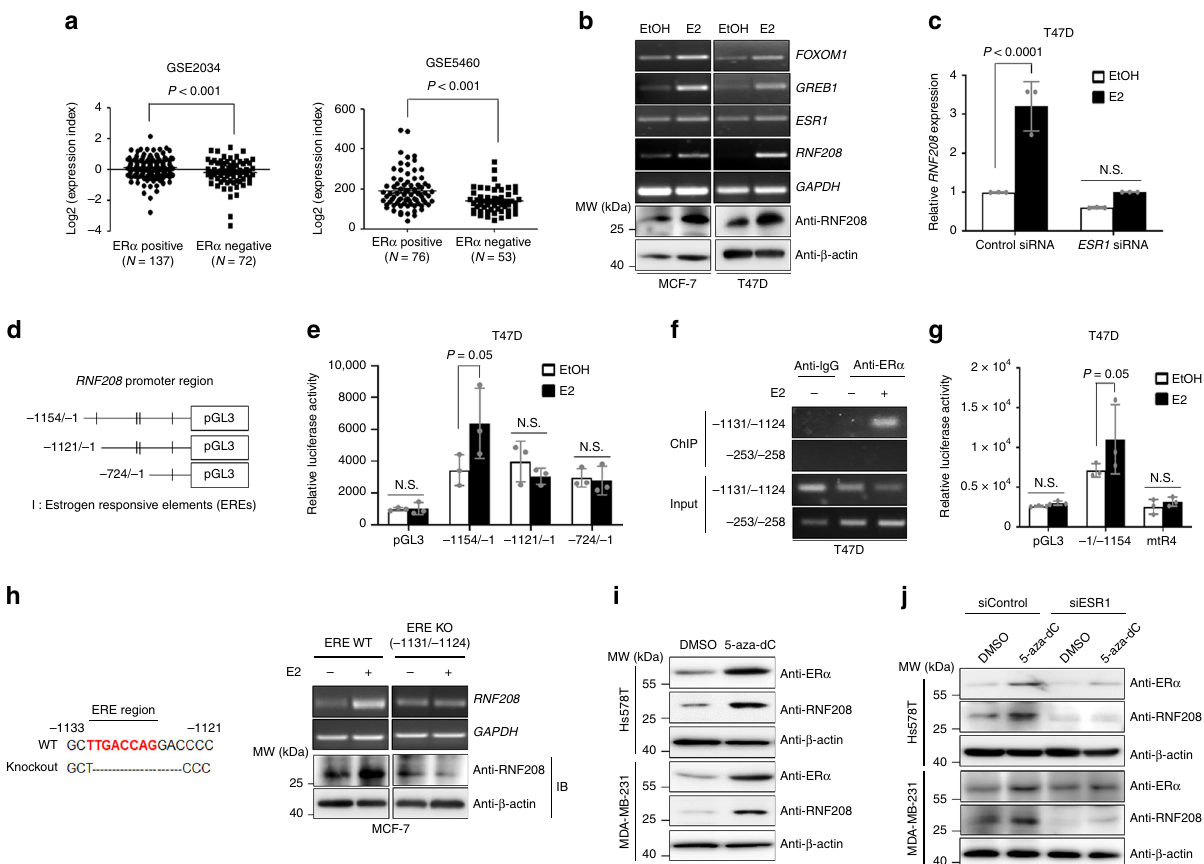
Fig. 2 RNF208 expression was transcriptionally activated by ER α in luminal breast cancer cells. a Comparison of RNF208 expression between ER α - positive and -negative breast cancer samples in published microarray datasets (GSE2034 and GSE5460). b RT-PCR (top) and immunoblot (bottom) analysis of ER α target genes ( FOXOM1, GREB1, ESR1 ) and RNF208 expression in EtOH- or E2-treated ER α -positive breast cancer cells. 10 nM or 20 nM of E2 was treated in MCF-7 or T47D cell, respectively and E2 was treated for 24 h for RT-PCR and 48 h for immunoblot analysis. GAPDH and β -actin were used as internal controls. c Real-time quantitative RT-PCR (qRT-PCR) of RNF208 expression in ESR1 -knockdown T47D cells upon E2 treatment. d Illustration of luciferase reporters including ER α -binding sites in the RNF208 promoter sequences. e T47D cells were transfected with various deletion constructs of